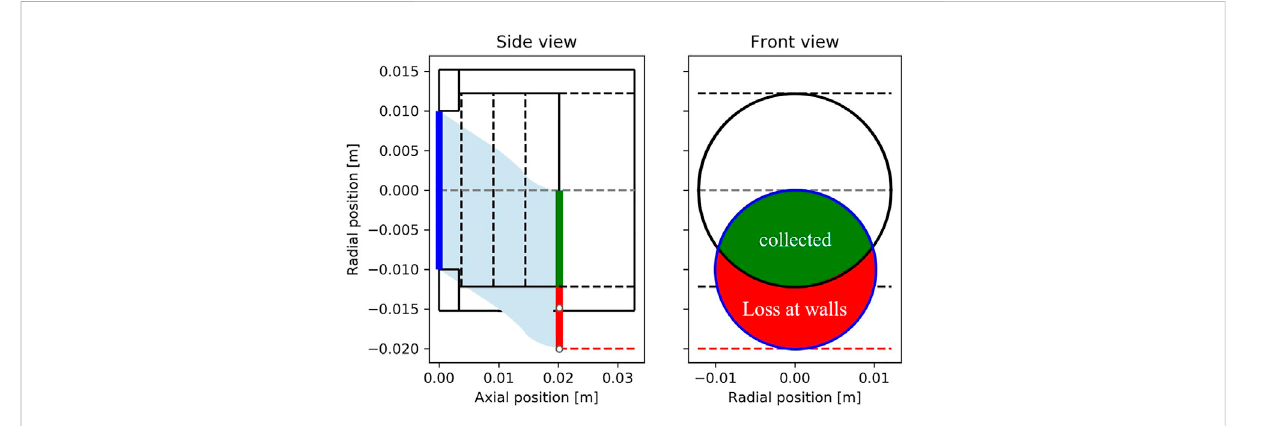
FIGURE 5 Transfer function H of the RPA for Xe + as a function of the kinetic energy and the RPA tilt-angle plotted for different values of the analyzer grid potential. The higher bound of the scale correspond to the grid transparency product τ . The β RPA dependency of the transfer function at 250eV is shown on the right. Parameter: ϕ CO (cid:2) − 30V